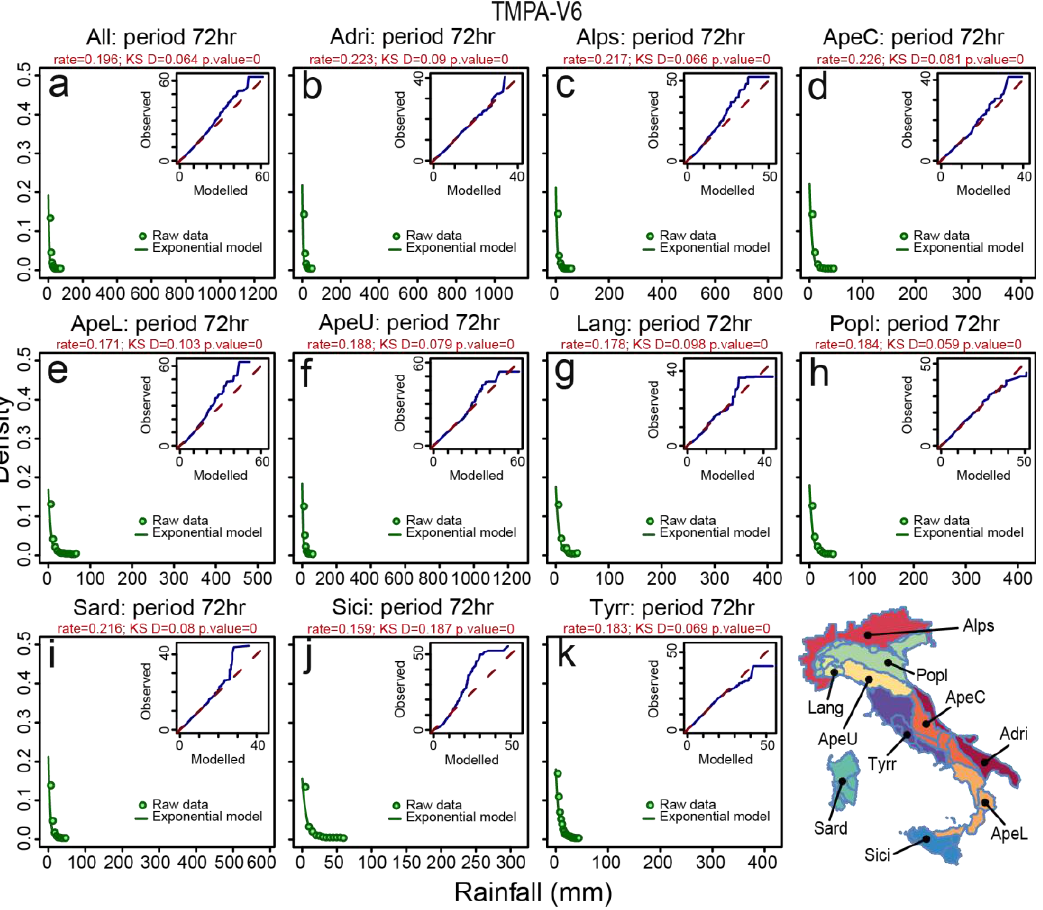
Figure 12. Exponential distribution estimated for 72-h cumulative rainfall using the MLE method for satellite estimates (TMPA-V6). The different plots show results for different Italian morphological subdivisions: ( a ) entire Italian territory; ( b ) Adri; ( c ) Alps; ( d ) ApeC; ( e ) ApeL; ( f ) ApeU; ( g ) Lang; ( h ) Popl; ( i ) Sard; ( j ) Sici; ( k ) Tyrr. The insets show QQ-plot measuring the fitting performance of the exponential model. KS D and p -value are two-sided bootstrapped Kolmogorov-Smirnov test statistics (see Table 6).